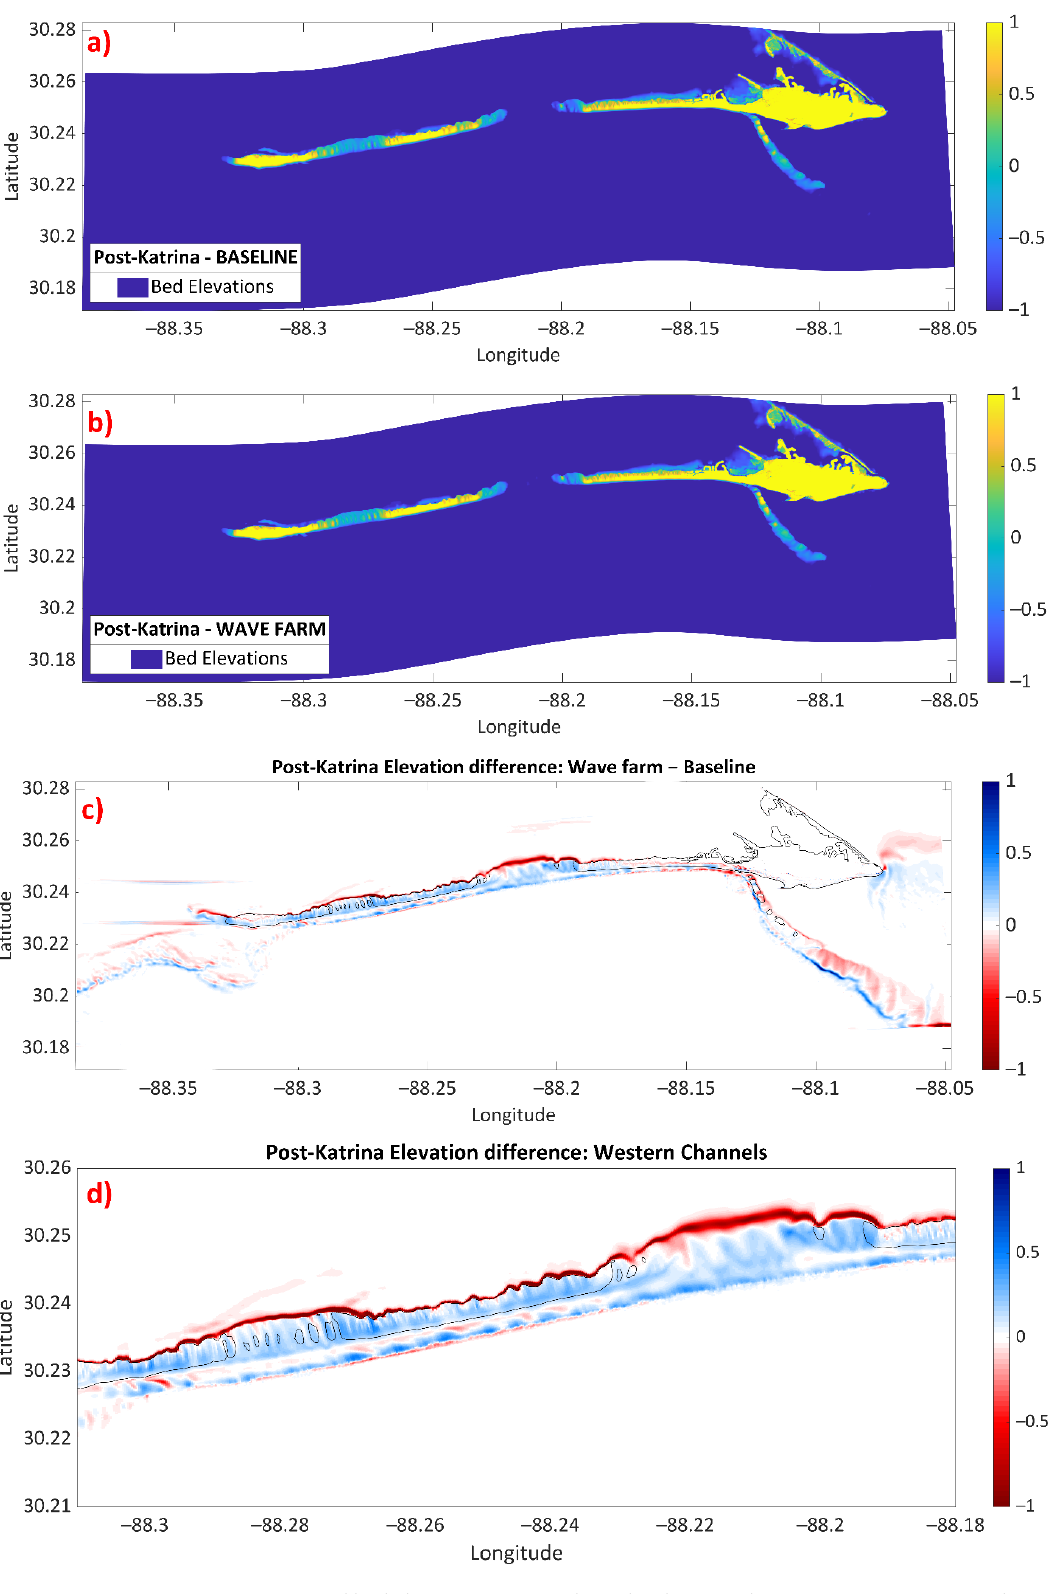
Figure 14. Final bed elevations at Dauphin Island, AL under Hurricane Katrina conditions for baseline ( a ) and wave farm ( b ) scenarios. ( c ) Difference between the two scenarios. ( d ) Magnified version of ( c ) showing the channels in the western portion—Positive (blue) values show the locations where the final elevations are higher in the wave farm scenario. Black lines are the poststorm zero-meter contours of the island.